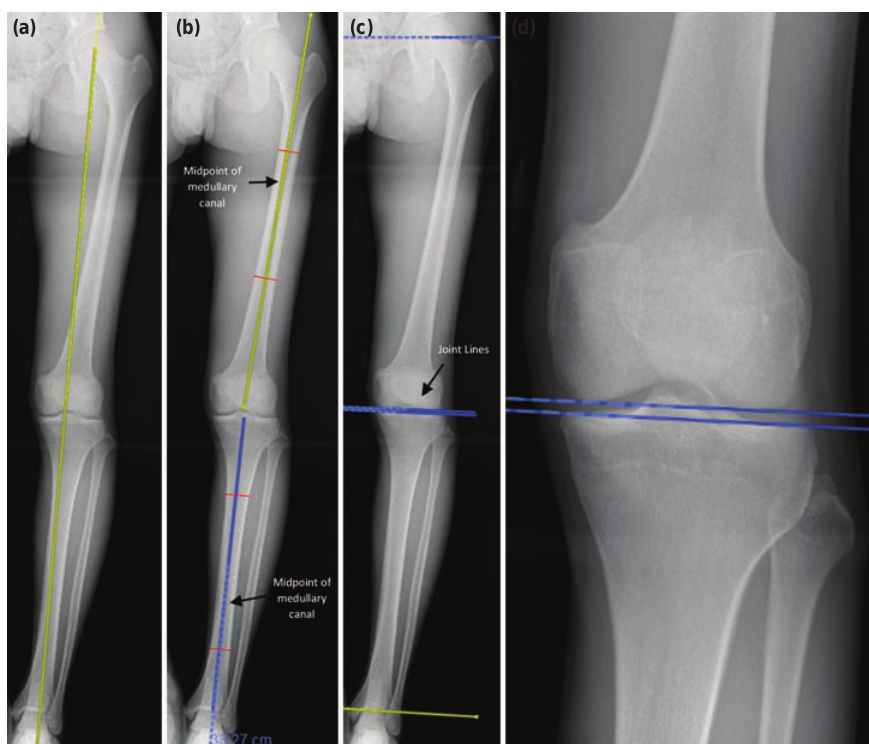
(a) Mechanical axis is drawn from the center of femoral head to the midpoint of the ankle. (b) Anatomical axis is drawn for both Fig. 1: femur and tibia by connecting the midpoint of the medullary canal. (c, d) Modified joint line convergence angle (mJLCA) is measured by comparing four imaginary lines. The four lines include a line from the center of femoral head to the proximal part of greater tuberosity, distal femur joint line, proximal tibia joint line and ankle joint